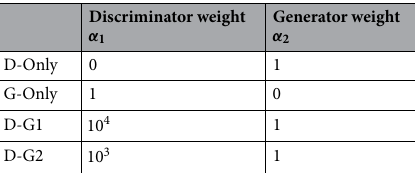
Table 1. α 1 and α 2 values for different learning